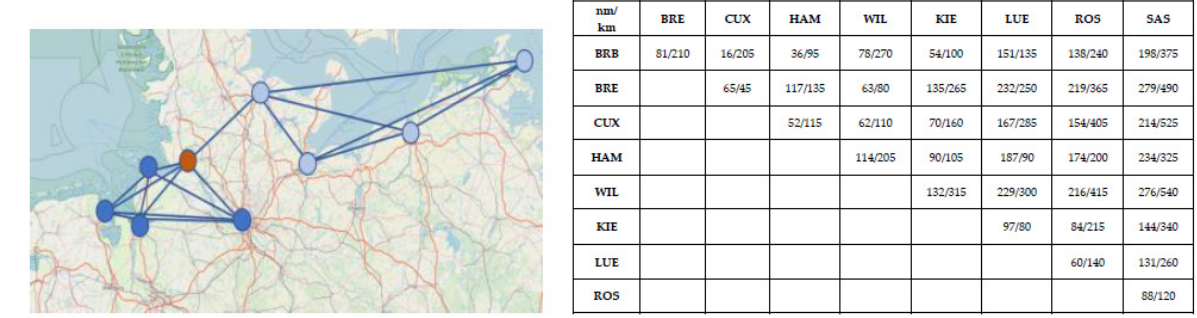
Figure 1. The transport and distance graph of German main ports.